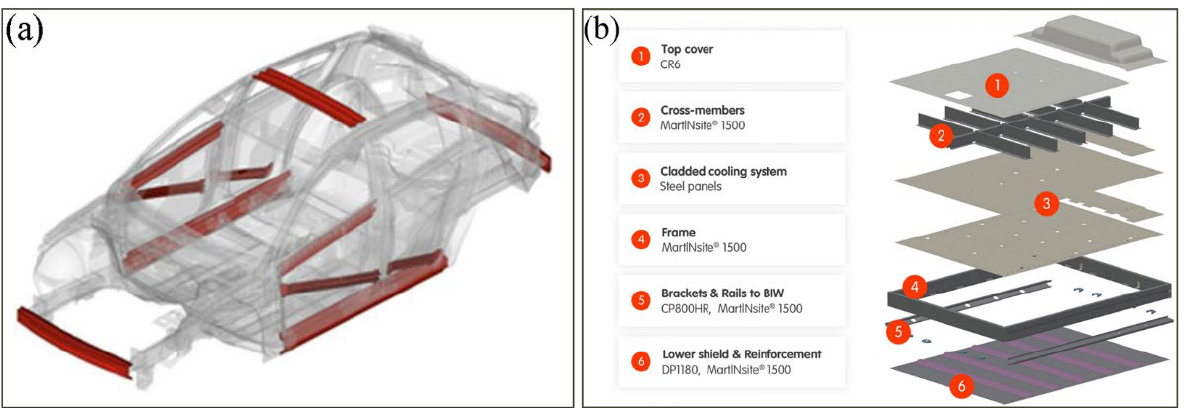
Figure 1. Application of ultra-high-strength cold-formed MS recommended by ArcelorMittal in automobile parts [29]. ( a ) Front and rear bumper beam, door beam, side member reinforcement, roof beam. ( b ) Support framework and frame of battery pack for new energy vehicles. This figure is reproduced based on